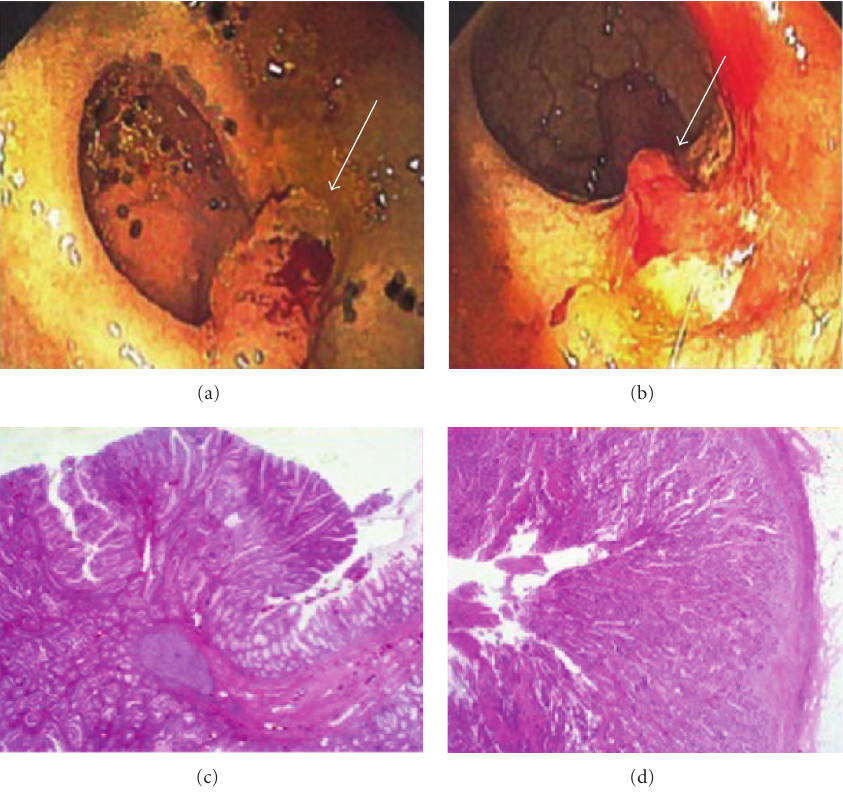
Figure 2: Colon fiberscopy demonstrates ulcerative adenoma (arrow; (a), (b)). Histopathology slides reveal the adenoma, hematoxylin and eosin stain 5 100. (c) and carcinoma invasion of the colon muscular layer, hematoxylin and eosin stain 5 200